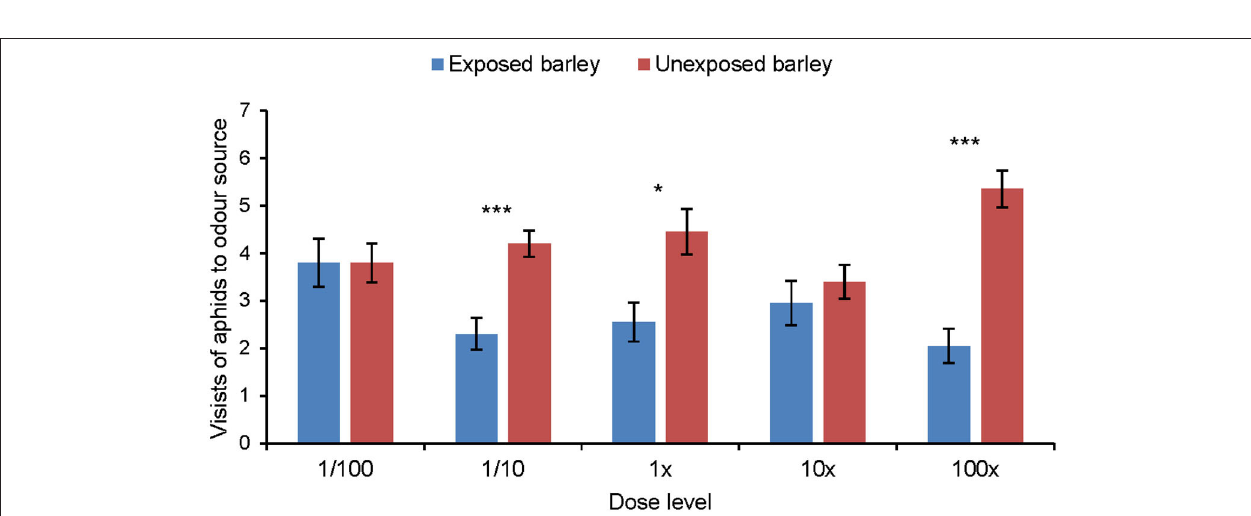
FIGURE 6 | Olfactory response of R. padi (mean visits in olfactometer arm ± SE) to different concentrations of a synthetic volatile blend resembling the headspace of unexposed barley plants or plants exposed to methyl salicylate, but with MeSA not included in the blend. * p ≤ 0.05; *** p ≤ 0.001 after Wilcoxon matched pairs tests.